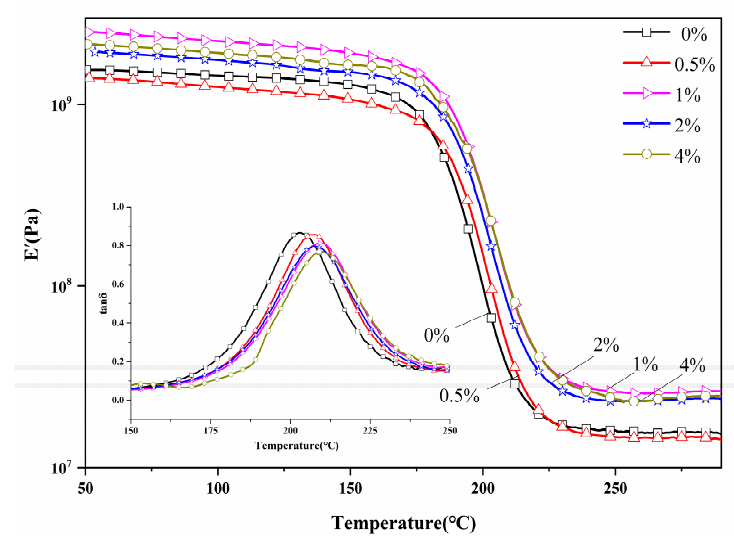
Figure 9. DMA curves of PBZ resins with different DDSQ-EP content.